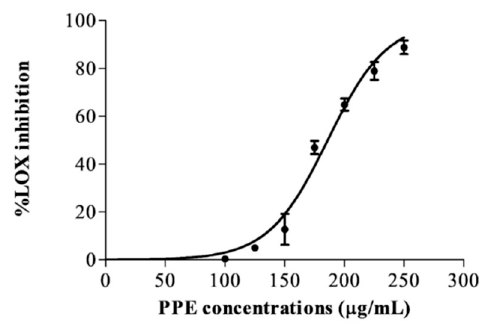
Figure 7. The % LOX inhibition of various concentrations of PPE (0–250